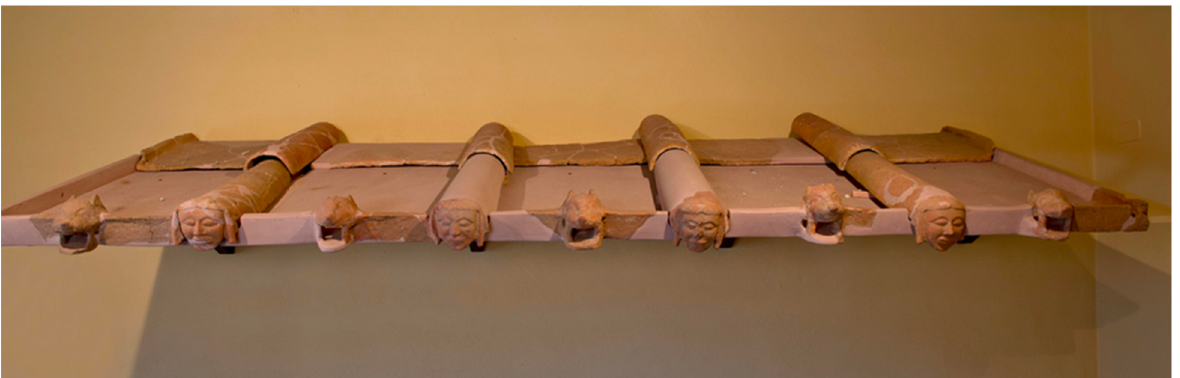
Figure 8. Orientalizing Complex Roofing Elements dating to 675/650-600 BCE, depicting alternating female heads and feline waterspouts as reconstructed in the Antiquarium di Poggio Civitate Museo Archeologico (Image: Poggio Civitate Project).